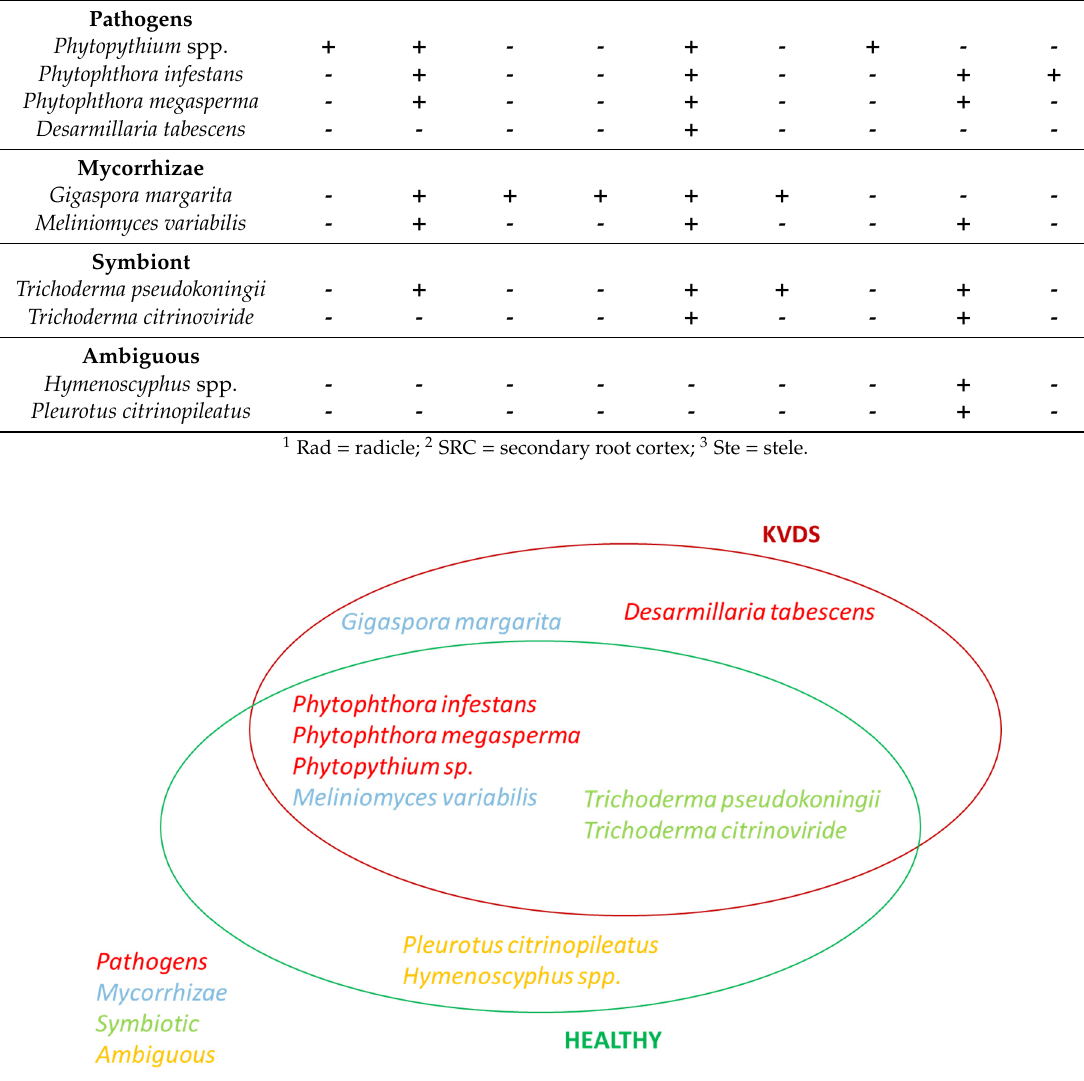
Figure 4. Composition of fungal community based on relative abundance (%) of different fungal isolates detected after sequencing the ITS region in the root tissues of affected or healthy vines. Data represent the average of 4 healthy (O3) and 8 KVDS (O1 + O2) root replicates. 3.3. KVDS Development after Experimental Inoculation Four pathogenic isolates were selected to be evaluated for pathogenicity on kiwifruit plants: Phytophthora infestans N3, Phytophthora megasperma N2-2, Phytopythium spp. GPW1 and Desarmillaria tabescens GPW3-1. Since the identification of the Phytopythium sp. strain. GPW1 could not discriminate between P. helicoides and P. fagopyri , the reference strains P. helicoides CBS 286.31 and P. fagopyri CBS 293 were included for comparison.